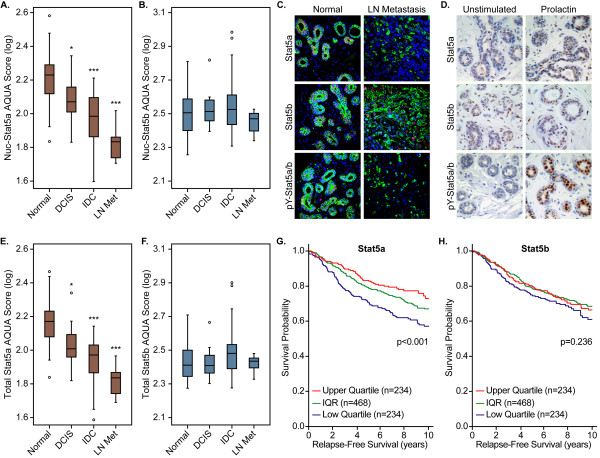
Nuclear localization of Stat5a (Nuc-Stat5a) is lost during breast cancer progression. (A) Detection of nuclear-localized Stat5a in Material I with immunofluorescence and quantified with AQUA revealed a significant reduction in Nuc-Stat5a protein in invasive ductal carcinoma (IDC; n = 66) and lymph node metastases (n = 19) when compared with normal breast tissue (n = 23) and ductal carcinoma in situ (DCIS; n = 18). (B) Levels of nuclear localized Stat5b (Nuc-Stat5b) remained unchanged between normal (n = 24), DCIS (n = 12), IDC (n = 67), and lymph node metastases (n = 13) in the same breast progression array (Material I). (C) Representative images of Stat5a, Stat5b, and pY-Stat5a/b detected with immunofluorescence in normal human breast tissue and lymph node metastases (Material I). Stat5a, Stat5b, pY-Stat5a/b, red (Cy5); cytokeratin, green (FITC); nuclei, blue (DAPI). (D) Stat5a protein (upper panels) translocated to the nucleus after ex vivo prolactin stimulation of human breast tissue explants, whereas prolactin induced only minimal nuclear localization of Stat5b protein (middle panels). Corresponding with enrichment of nuclear Stat5a protein in response to prolactin, tyrosine-phosphorylated Stat5a/b (pY-Stat5a/b) was induced in the nuclei of the same breast tissue after ex vivo stimulation with prolactin (lower panels). (E, F) Levels of total cellular Stat5a protein (E), but not total cellular Stat5b protein (F), were significantly reduced over breast cancer progression (Material I). (G, H) Stat5a mRNA expression levels in human breast tumor tissue (Material II) were associated with relapse-free survival (G), whereas Stat5b mRNA expression levels were not associated with relapse-free survival (H). Statistical differences (ANOVA, Dunnett T3 post hoc test) in levels of nuclear and total cellular Stat5a or Stat5b over breast cancer progression in relation to normal histologic type are indicated. ***p < 0.001; *p < 0.05. AQUA, Automated Quantitative Analysis; DCIS, ductal carcinoma in situ; IDC, invasive ductal carcinoma; IQR, interquartile range; LN Met, lymph node metastasis.